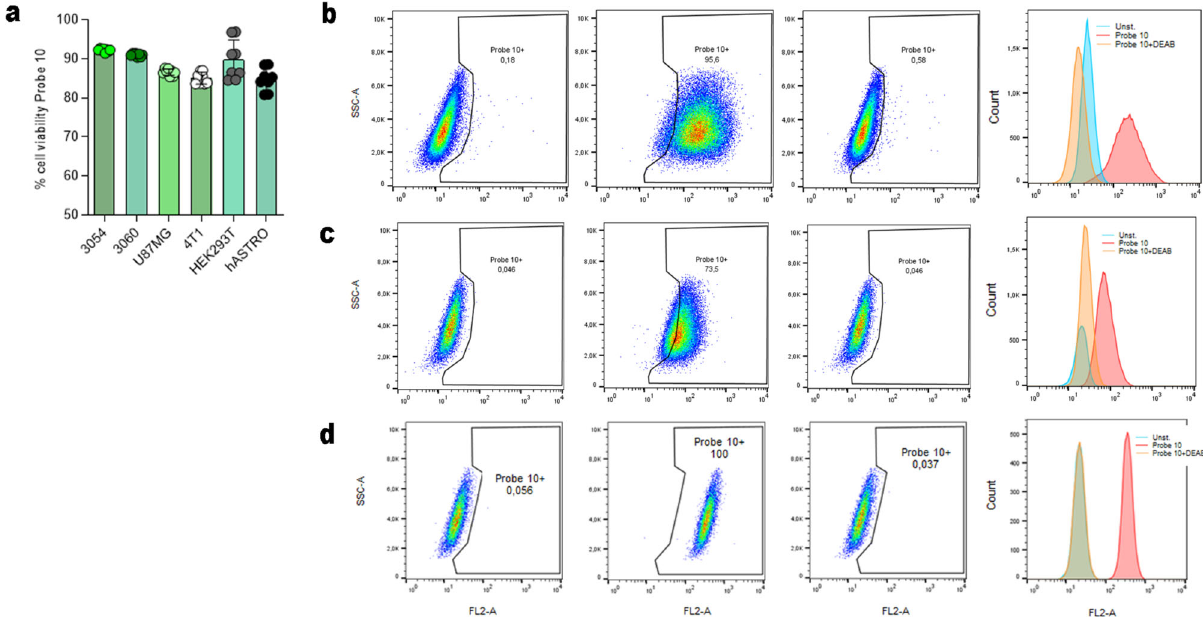
Fig. 6 Application of Probe 10 in glioblastoma cell lines. a Cell viability at 10 µ M of Probe 10 at 72 h. Flow cytometry analysis of b 3054, c 3060, d U87- MG cells unstained, stained with Probe 11 (10 µ M) with or without DEAB (1 µ M). On the right of each panel of fl ow cytometry histographic pro fi les of unstained, stained with Probe 10 (10 µ M) with or without DEAB (1 µ M) is